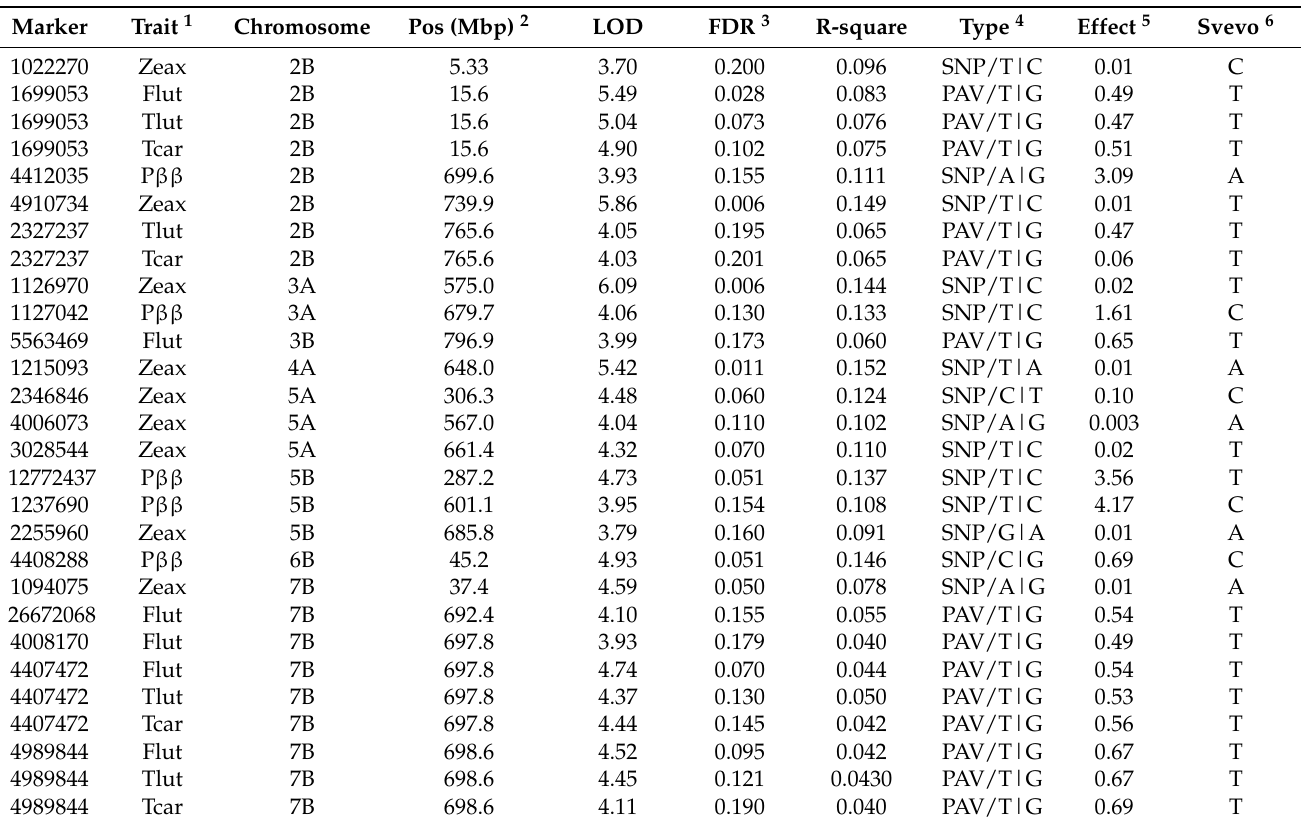
Table 1. Marker-trait associations (MTAs) identified for carotenoid content and profile and DArTseq